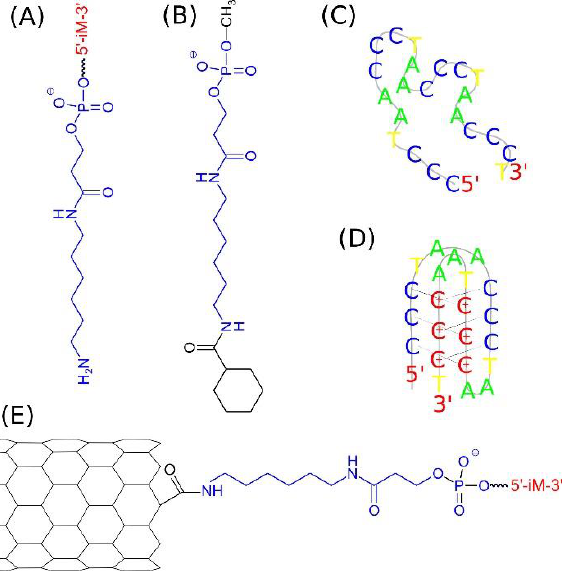
Figure 1. Essential components of the analyzed systems. ( A ) amino DNA linker composed of 5′ amino C6 linker (blue) and iM sequence (red); ( B ) template molecule of the amino C6 linker used for computation of atomic partial charges; ( C ) random coil of the DNA iM sequence at neutral pH; ( D ) iM sequence folded into i-motif structure at acidic pH; ( E ) on tip functionalized carbon nanotube by amino DNA linker with the iM sequence.